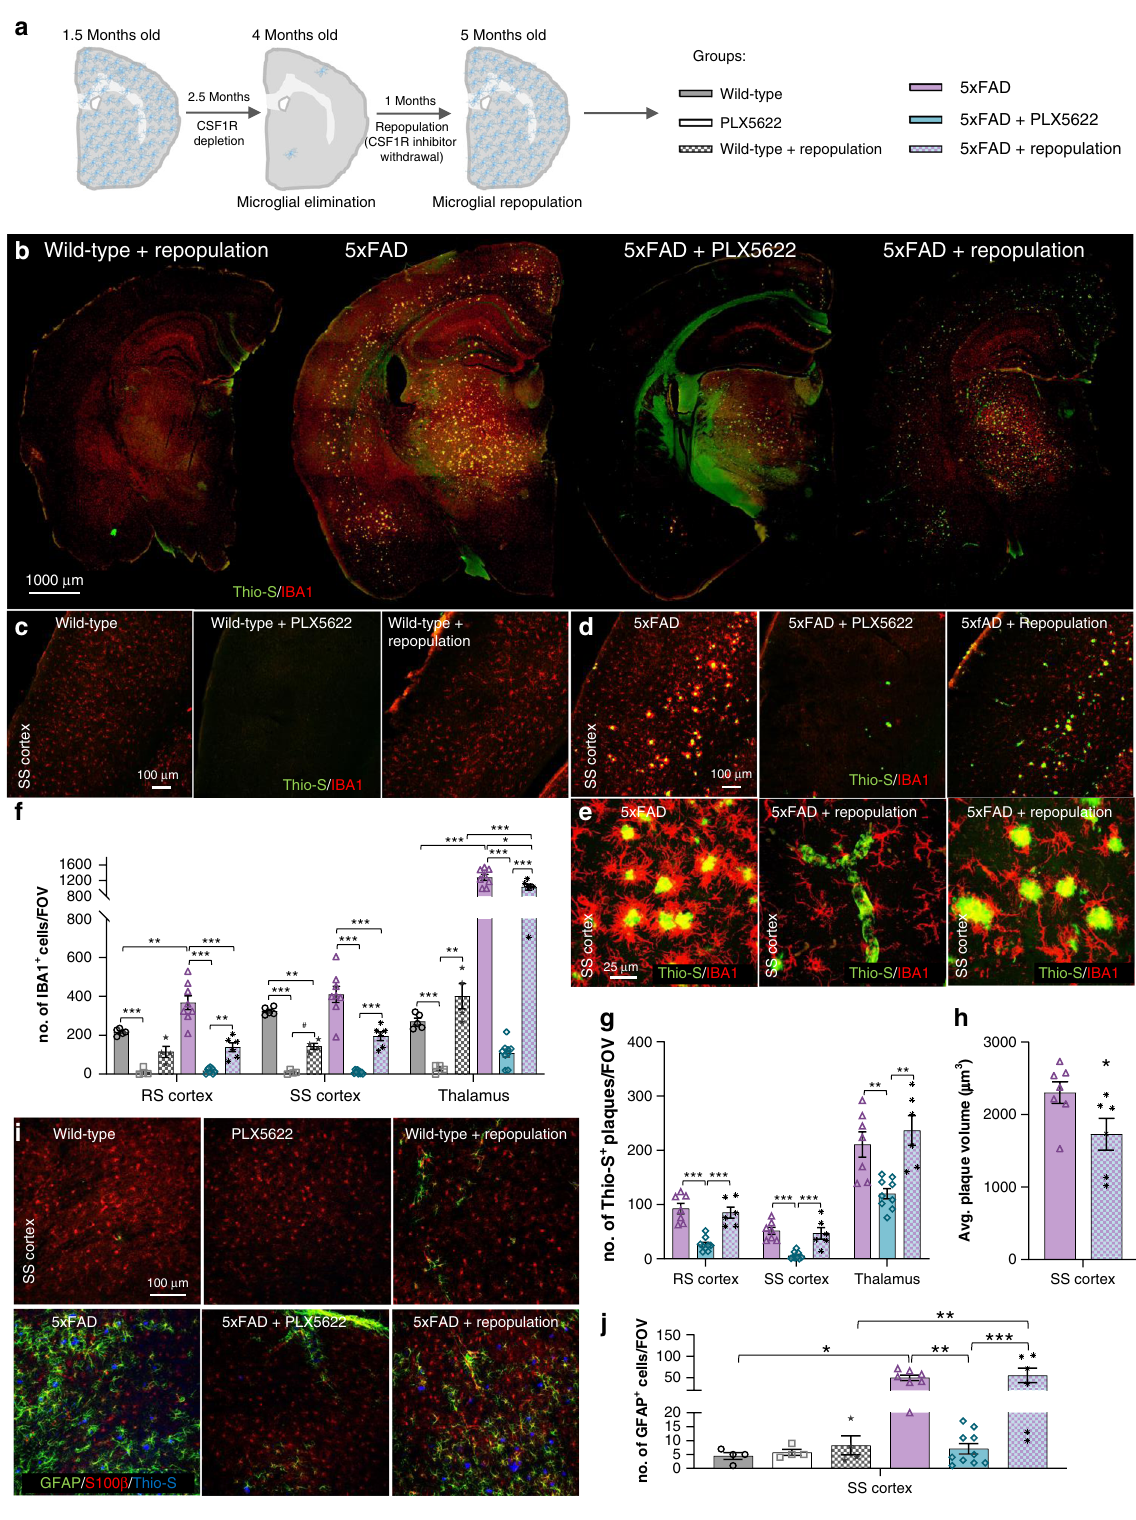
assumed to be normal, but this was not formally tested. Symbols denote signi fi cant differences between groups: * p < 0.05, ** p < 0.01, and *** p <0.001. Statistical trends are accepted at p < 0.10 ( # ). Data are presented as raw means and standard error of the mean (SEM). Reporting summary . Further information on research design is available in the Nature Research Reporting Summary linked to this